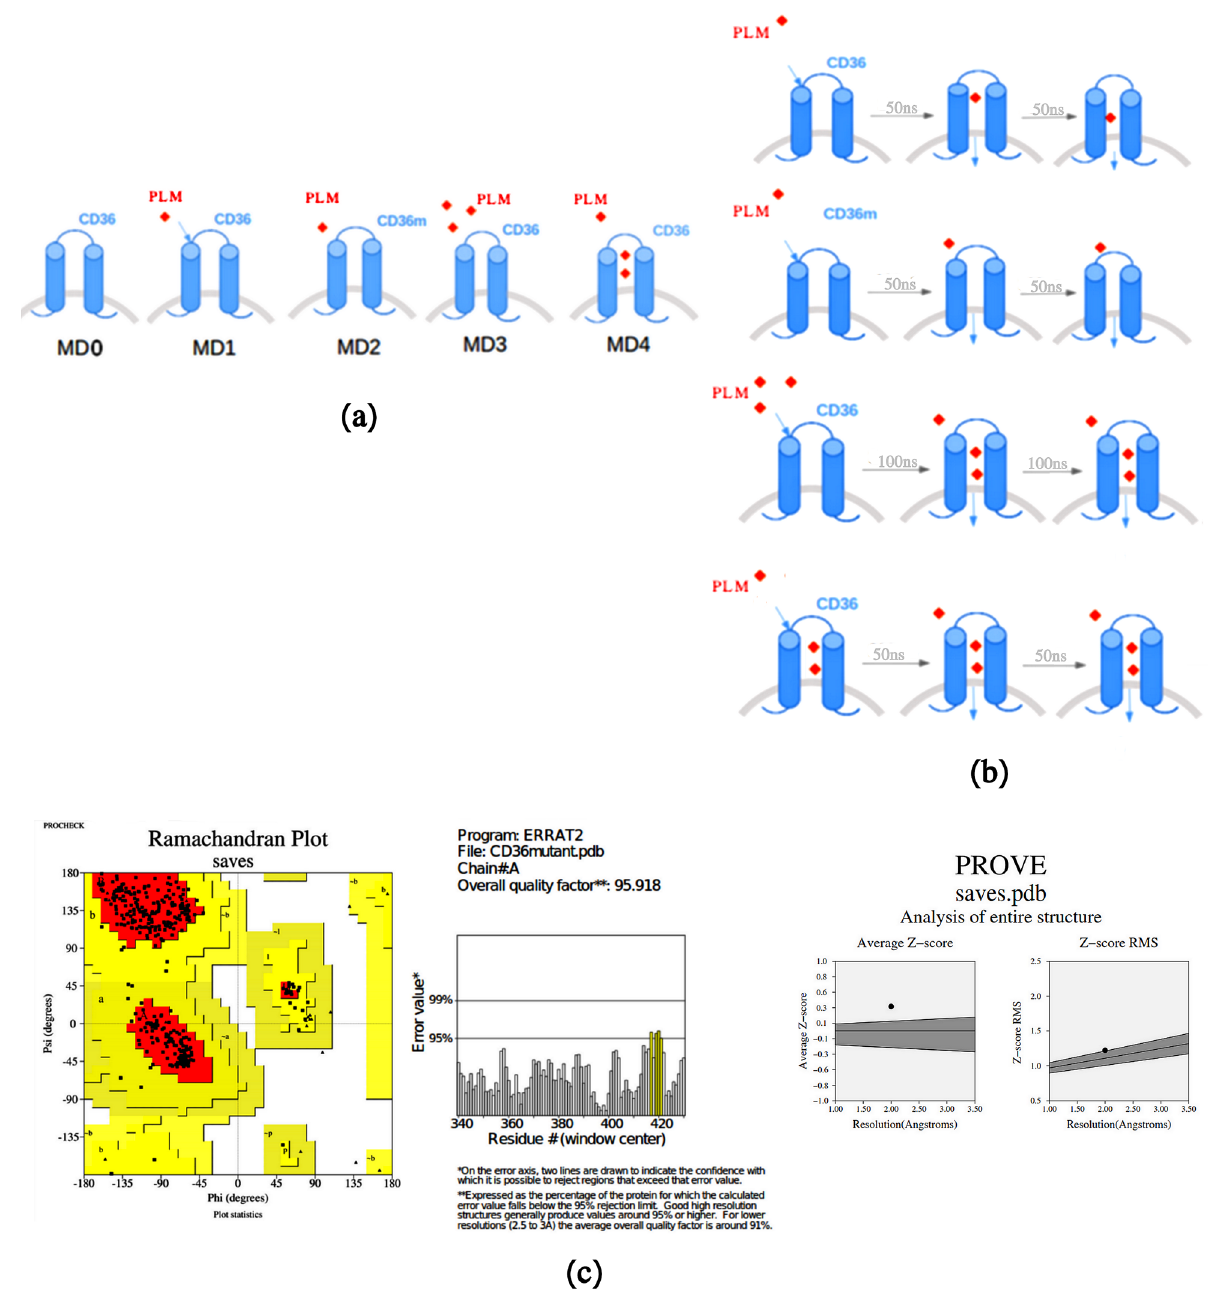
Figure 1. ( a ) Scheme of the molecular dynamics simulation procedure that the CD36 transporter (blue) and ligand plamitic acid PLM (reed). MD0 The wild type CD36 protein was simulated in the absence of palmitic acid (PLM), MD1 the wild type CD36 protein was simulated in the presence of a single PLM, MD2 the mutant type CD36 protein was simulated in the presence of a single PLM, MD3 the wild type protein was simulated in the presence of a three PLM put outside, MD4 the wild type protein was simulated in the presence of a three PLM (two PLM put inside and one PLM outside). ( b ) Scheme of molecular dynamic results that the CD36 transporter (blue) and ligand plamitic acid PLM (reed) including the efflux of the substrate PLM along with the uptake across the CD36 receptor. ( c ) Evaluation of the mutant K164A CD36 (3D) structure by ERRAT2 and Prove and Ramachandran